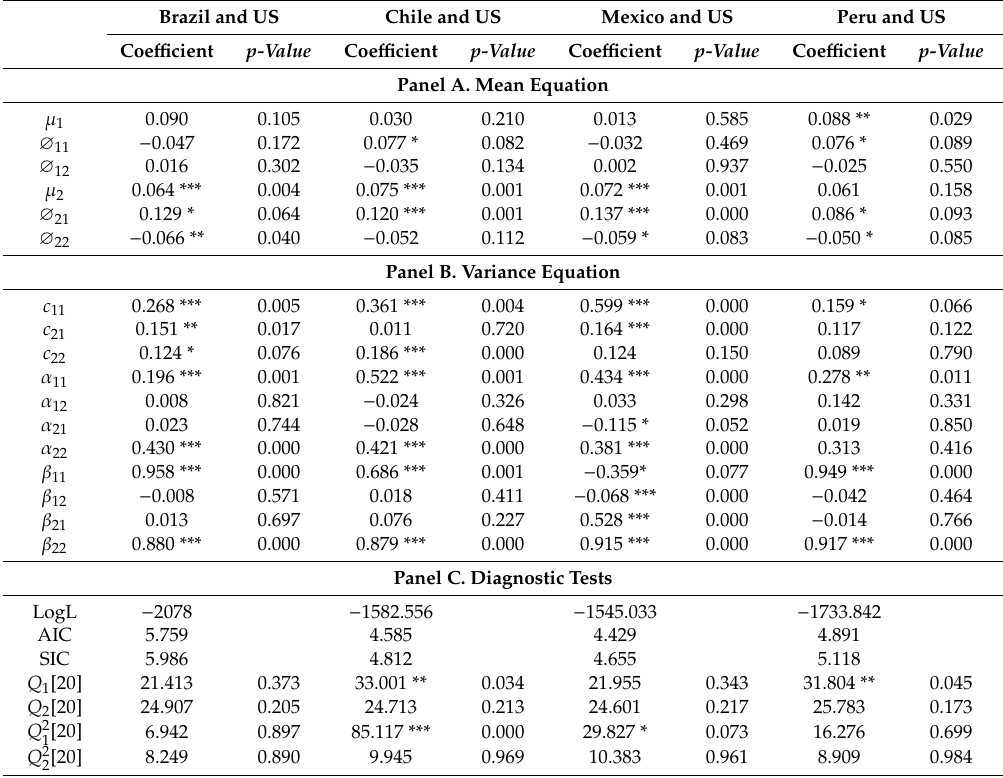
Table 5. Estimates of BEKK-GARCH for the US and Latin American stock markets during the crash of the Chinese stock